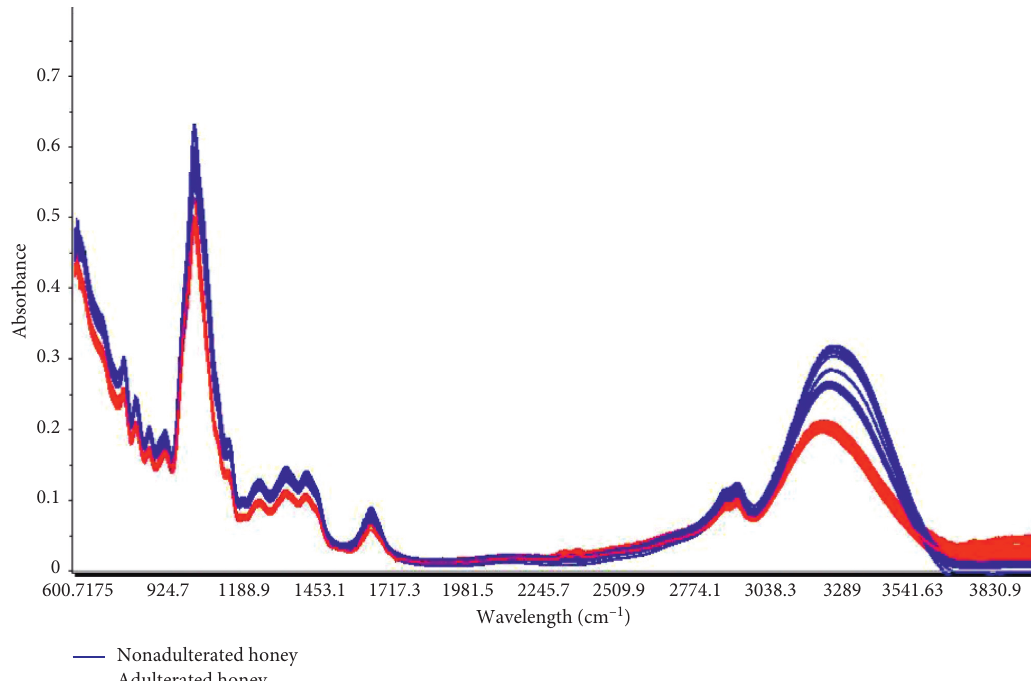
Figure 3: Mid-infrared spectrum of pure honey and adulterated